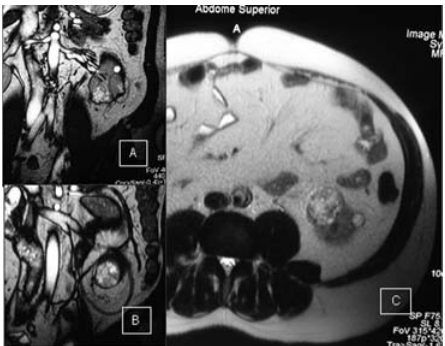
Figure 2 - Post-contrast abdominal coronal (A and B) and transverse (C) magnetic resonance imaging showing three contiguous enhanced masses in the inferior half of the left kidney (size varying from 3 to 4